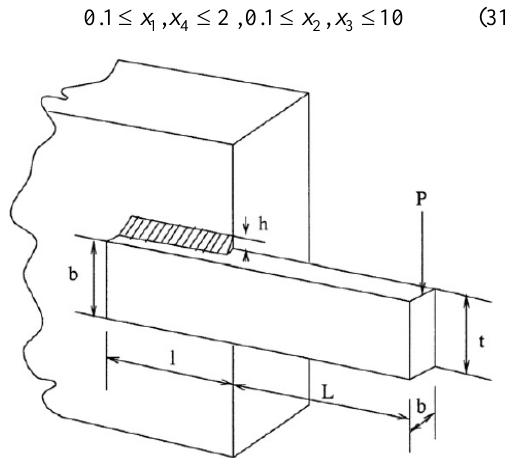
Figure 2. The welded beam design problem.